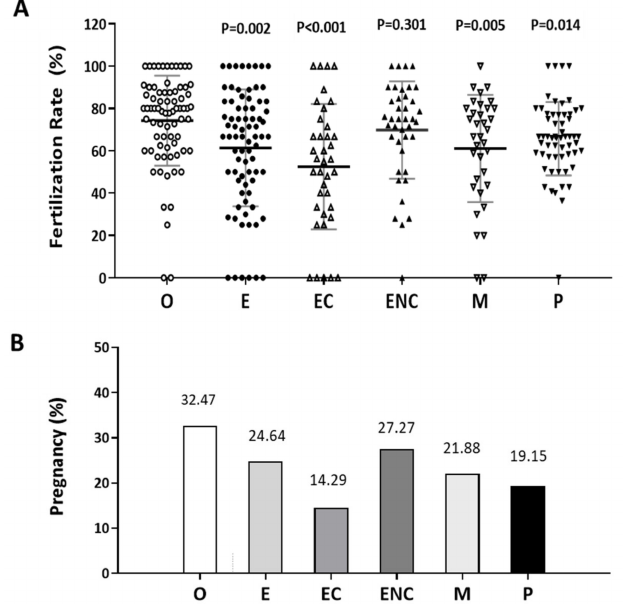
Figure 1. Comparison of the pregnancy and fertilization in the di ff erent groups as an indication of infertility. The ( A ) fertilization rate and ( B ) pregnancy rate in each group were counted. The infertile individuals were characterized into six groups: other female factors (O, female factor without endometriosis and PCOS), endometriosis (E), ovarian endometrioma (EC), endometriosis without ovarian endometrioma (ENC), male factor (M), and polycystic ovary syndrome (P). The fertilization rate and pregnancy outcome values were significantly lower in the EC group than they were in the other groups. The p -value for each group versus the group with other female factors was determined by an unpaired t